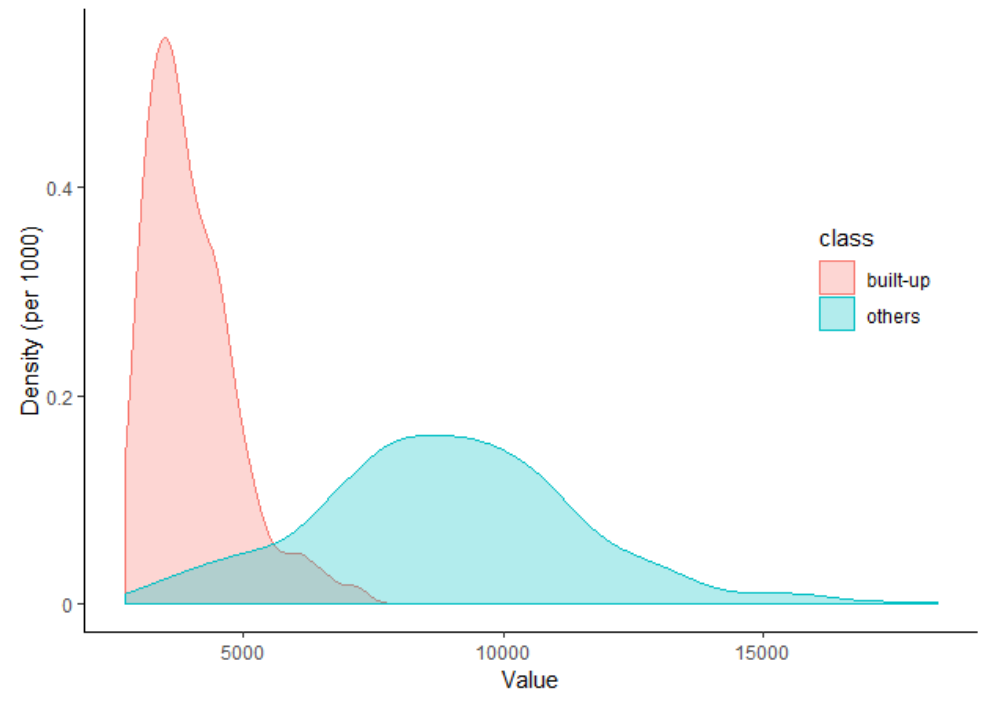
Figure 6. Distribution of smoothened NDDBI values in reference points of the “built-up” class and “others” class collected across the years from 2000 to